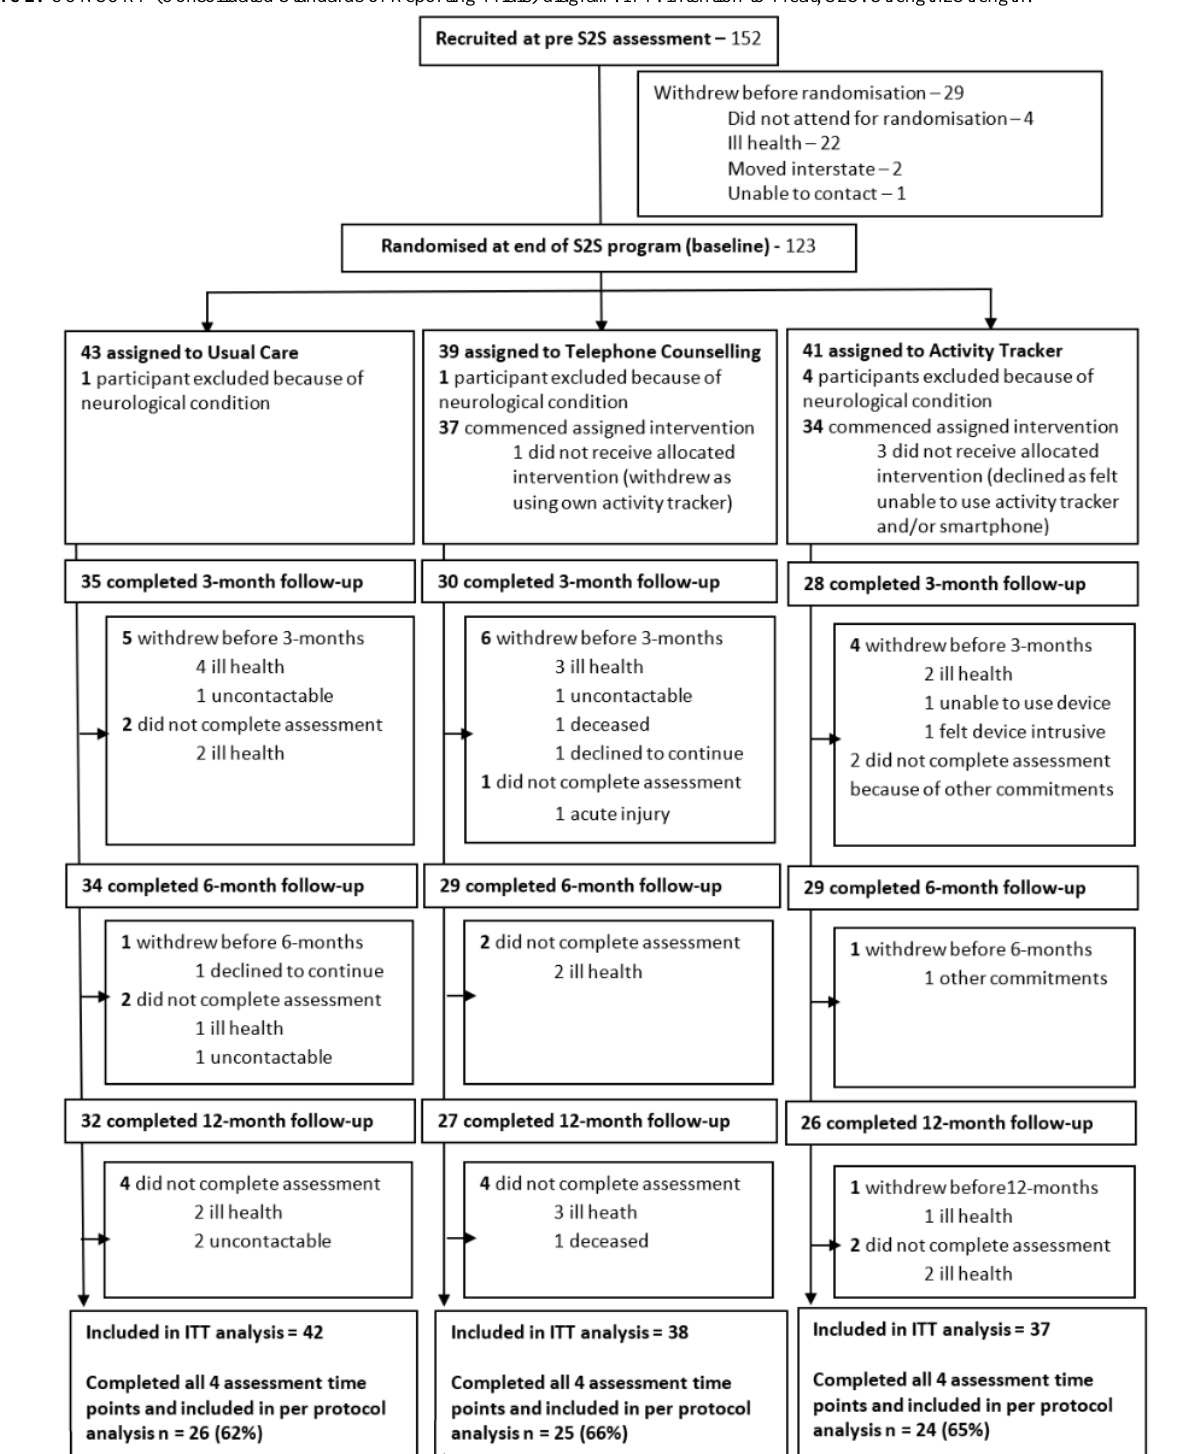
Figure 2. CONSORT (Consolidated Standards of Reporting Trials) diagram. ITT: Intention to Treat; S2S: